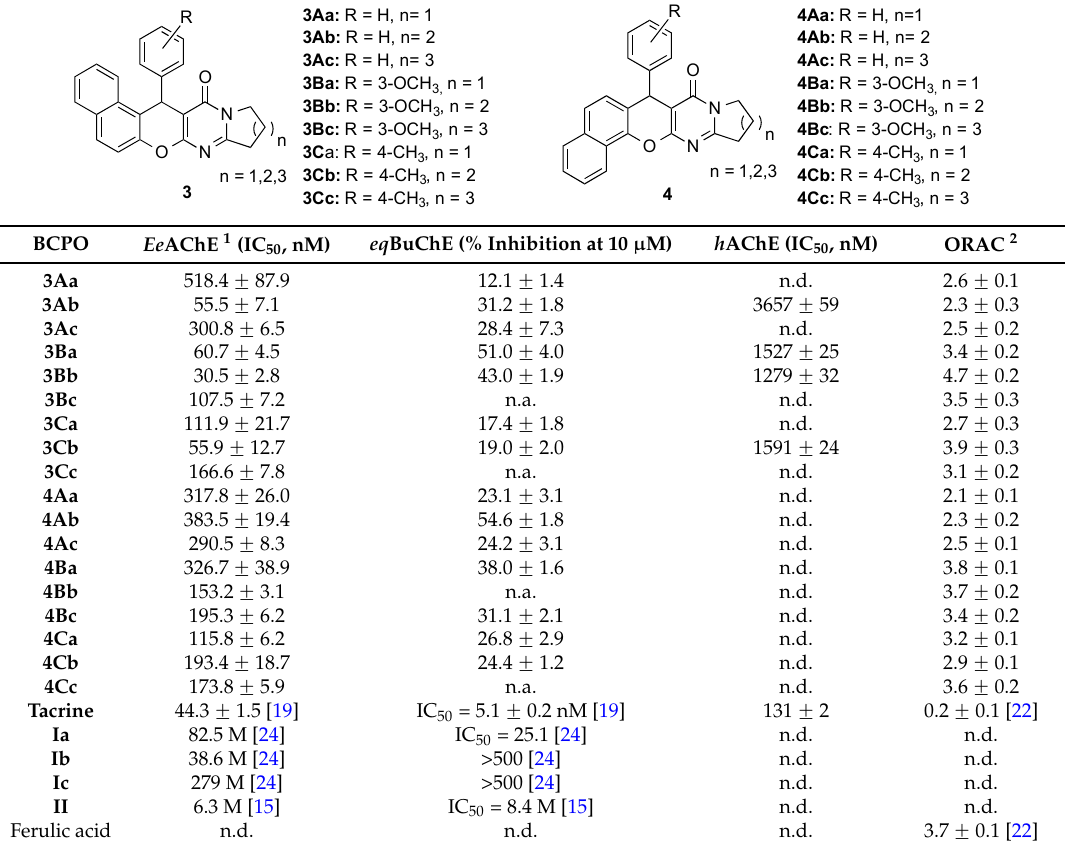
1 IC 50 values were obtained by nonlinear regression. Ee : electric eel, eq : serum horse, h : human. Each IC 50 value is the mean ± SEM of at least three independent experiments. 2 Data are expressed as Trolox equivalents and are shown as mean ± SD. n.a.: Not active (any inhibition was observed). n.d.: not